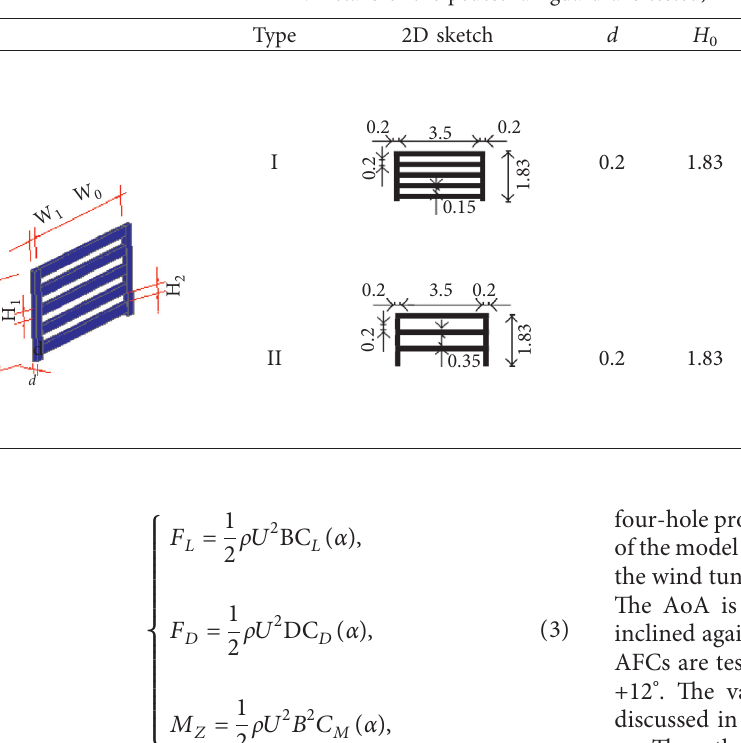
Table 2: Details of the pedestrian guardrails tested, in 1/60 scaling ratio